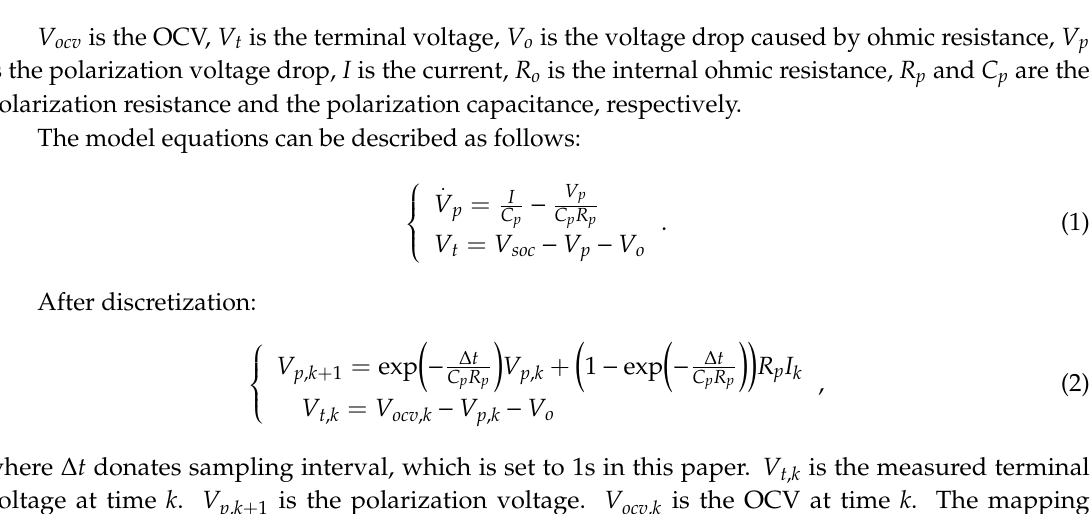
Figure 2. The Thevenin model.